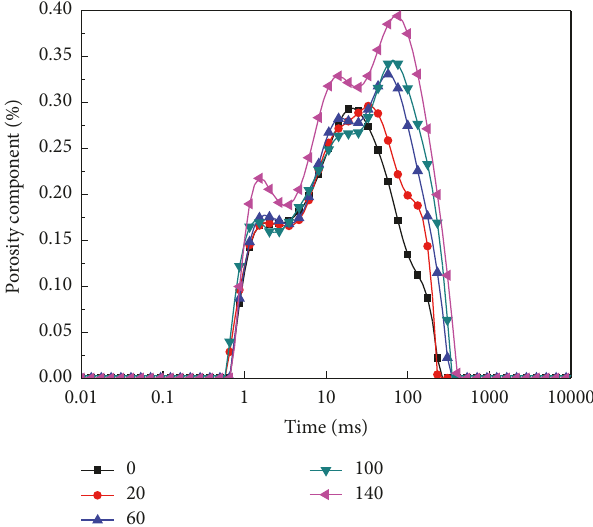
Figure 5: The 𝑇 2 distribution variation of sandstone under the number of freeze-thaw cycles from 0 to